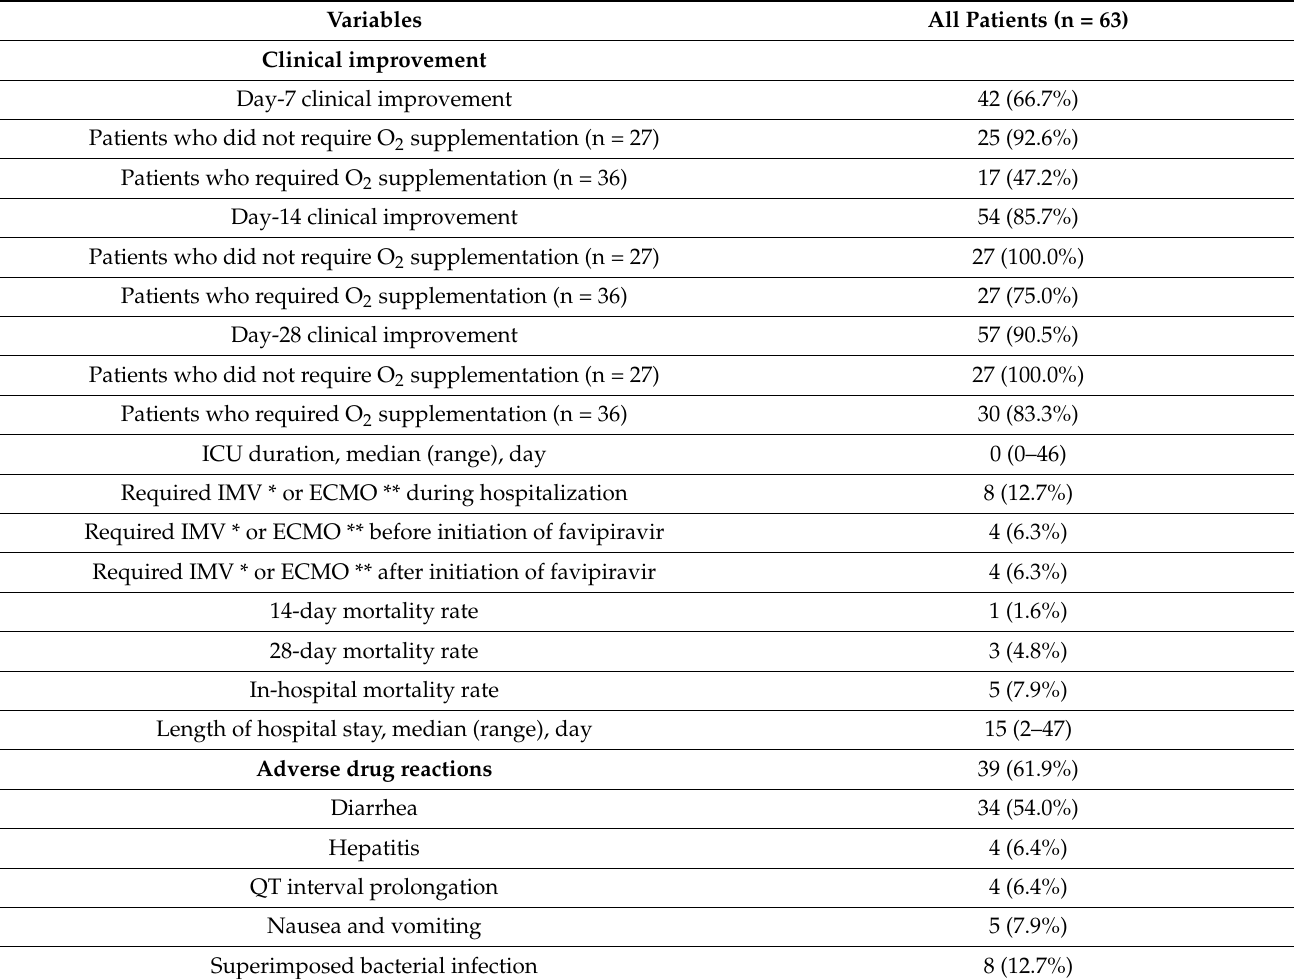
Table 2. Hospital course and treatment